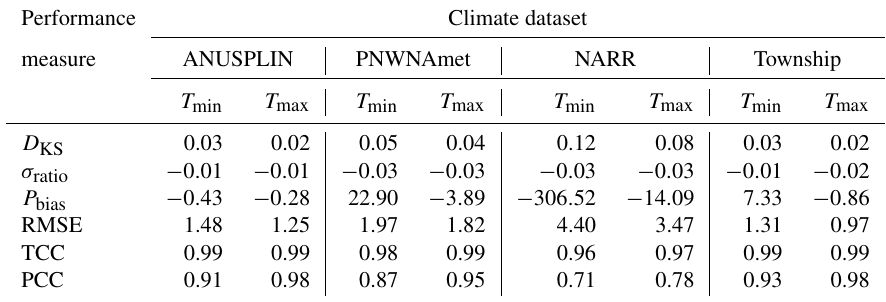
Table 4. Performance measures averaged over the AHCCD stations in Alberta for minimum and maximum temperature.